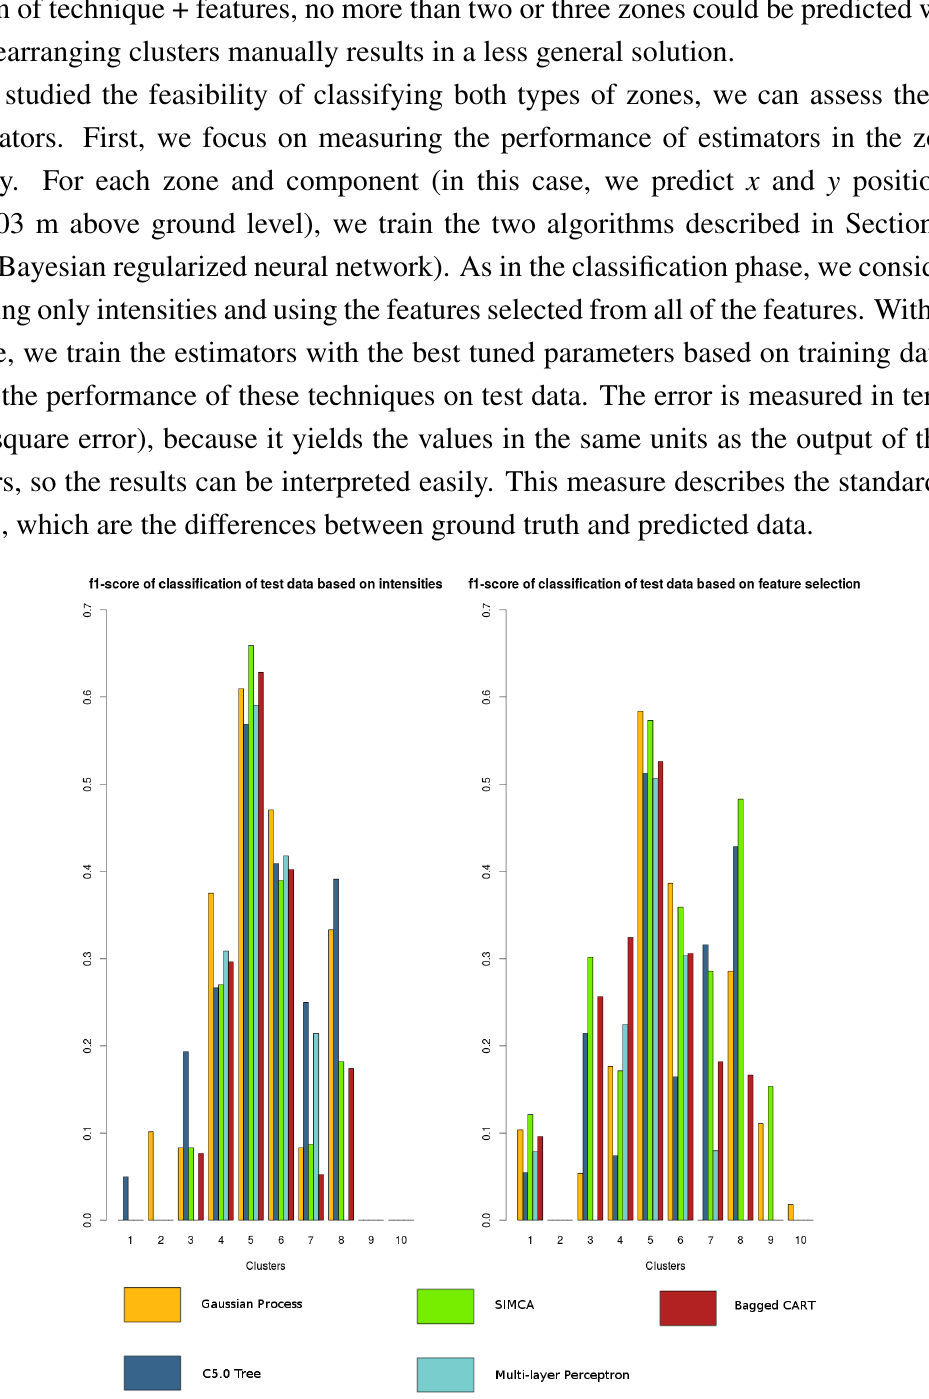
Figure 9. Classification results of manually-clustered data in Building